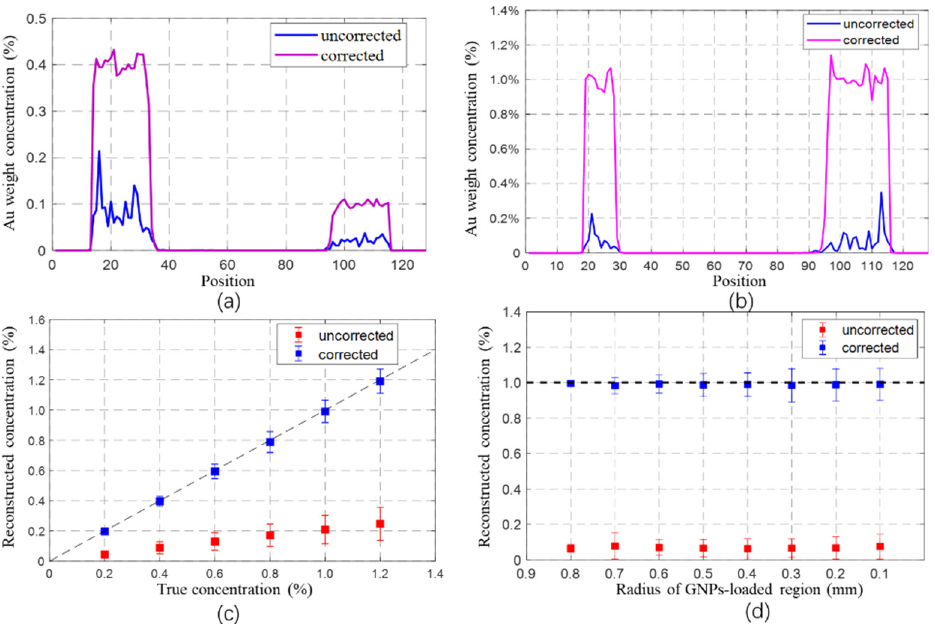
Figure 8. Profiles (red lines in Figure 7) through the phantom A and B shown in ( a , b ), respectively. Au weight concentration reconstructed by MLEM without correction and with correction shown in ( c , d ).